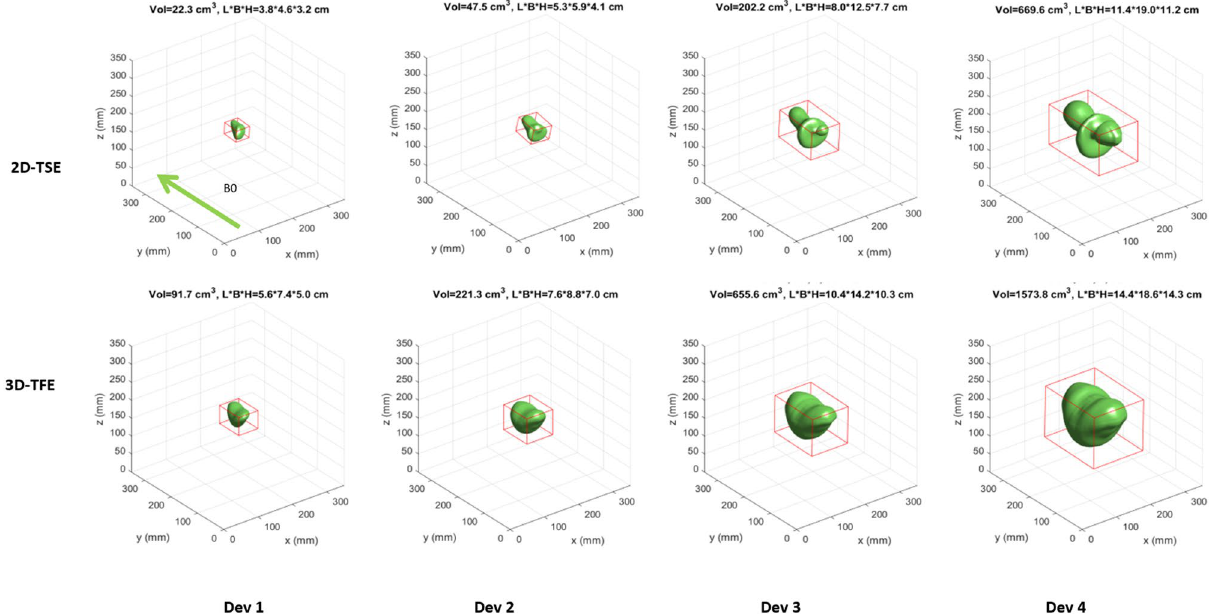
Figure 3. Segmented signal voids induced by the implants Dev1-4 scanned with the 2-DTSE and the 3D-TFE sequences in orientation 1. The red box in each coordinate system represents the boundary box. The absolute values of the boundary box are given below the coordinate system. Dev 1: cardiac loop recorder. Dev 2: Pacemaker, Dev 3 and 4: ICDs. For results in orientation 2 and 3 see Supplemental Figs. 2 and